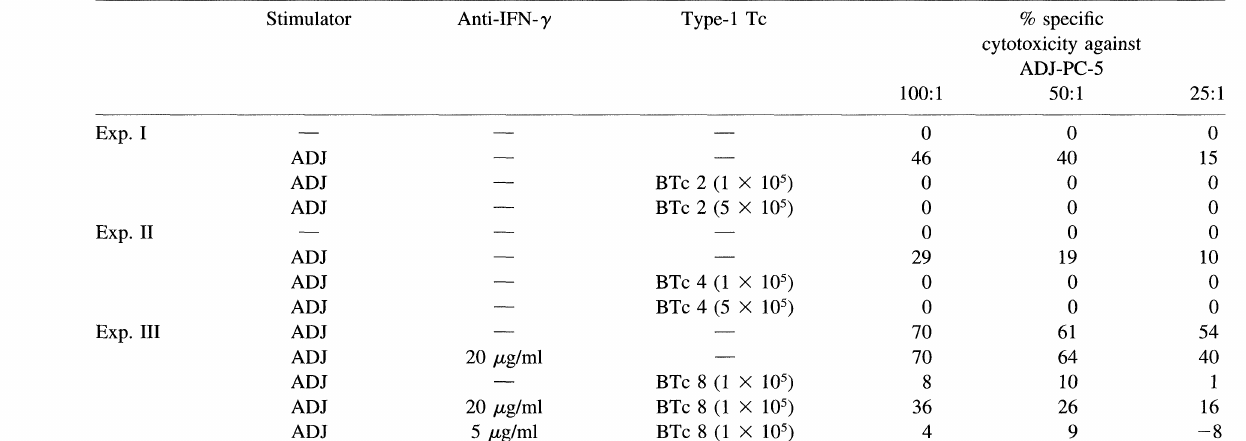
TABLE III Suppression of ADJ-PC-5-Specific Tc Induction in a Primary MLTC by ADJ-PC-5-Specific Type-1 Tc Lines Stimulator Anti-IFN- 3/ Type-